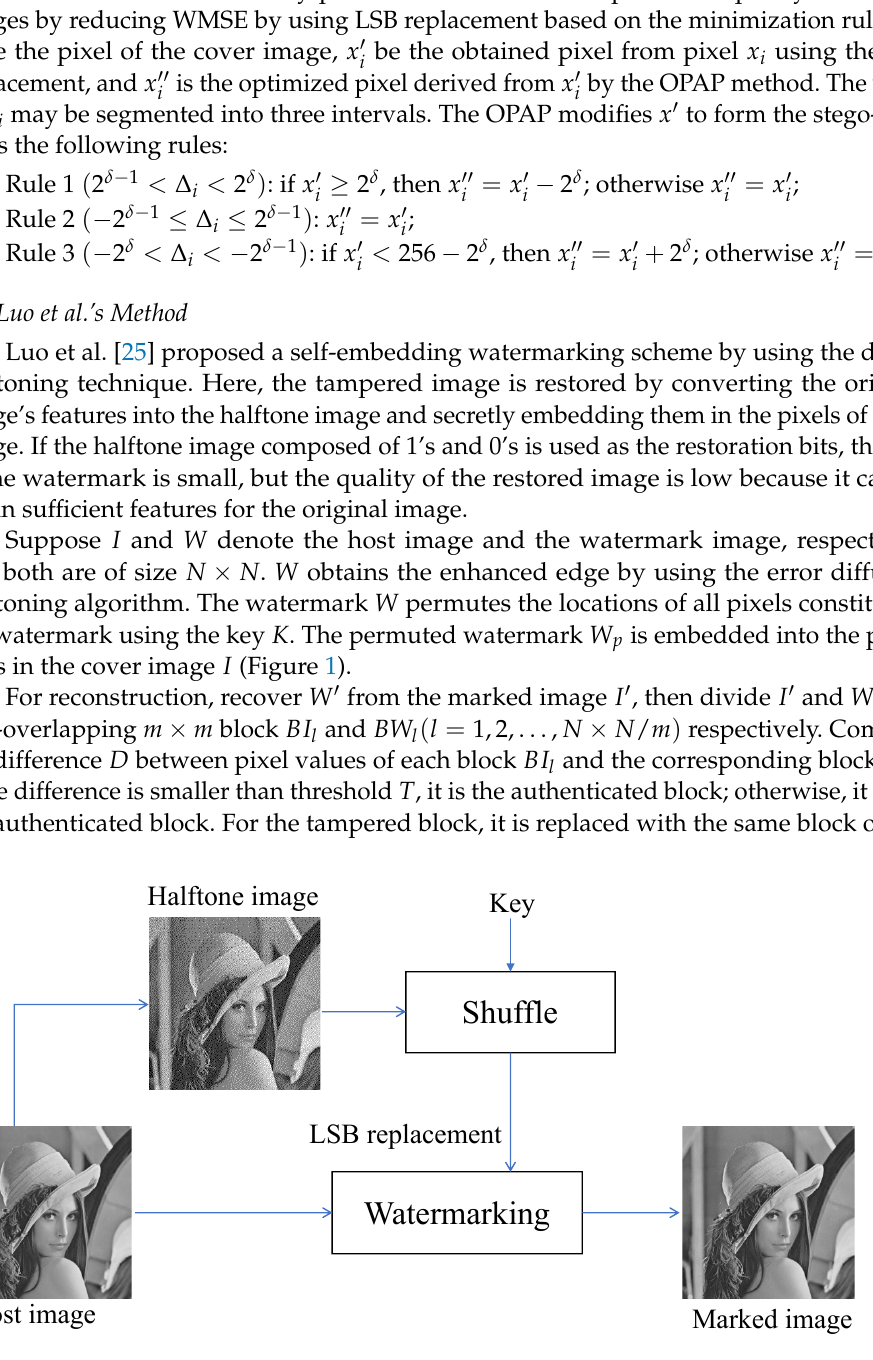
Figure 1. Block diagram of the proposed scheme—watermark generation and